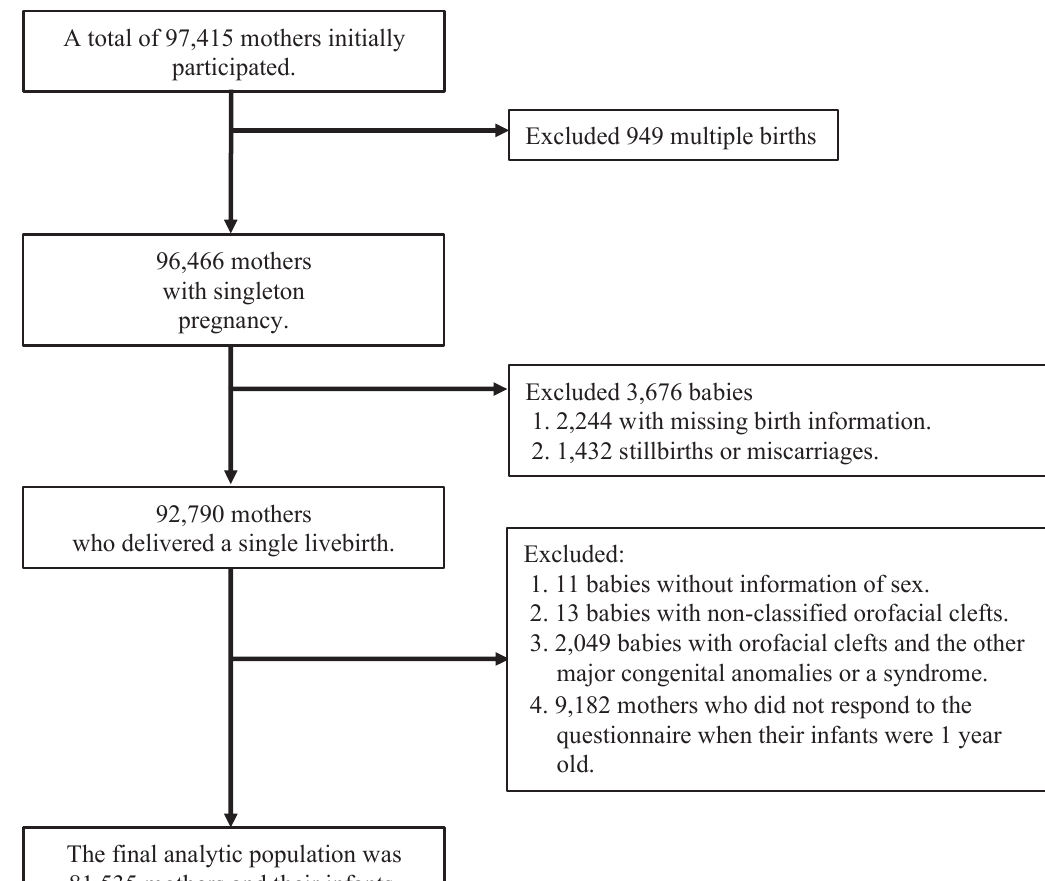
Figure 1. Flowchart of the selection of